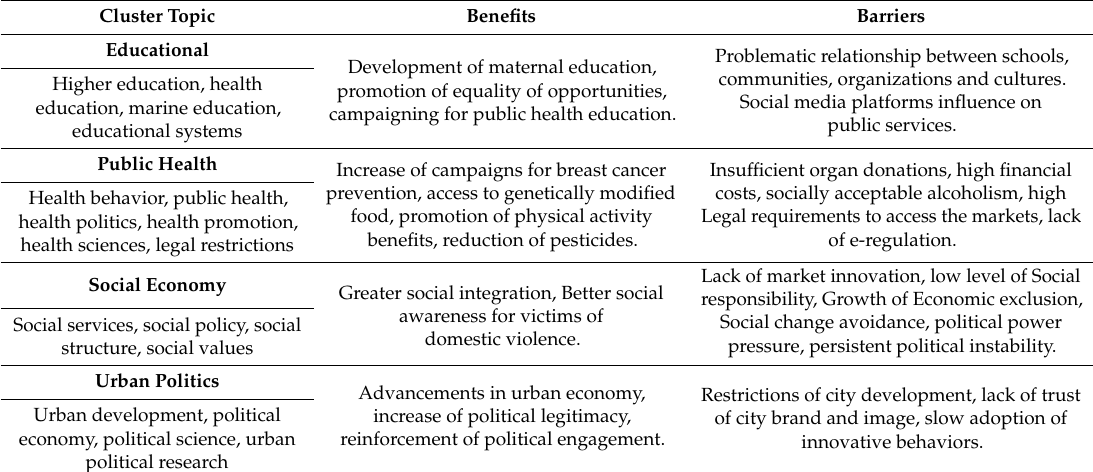
Table 2. Main benefits and limitations in the marketing of public sector (MPS).